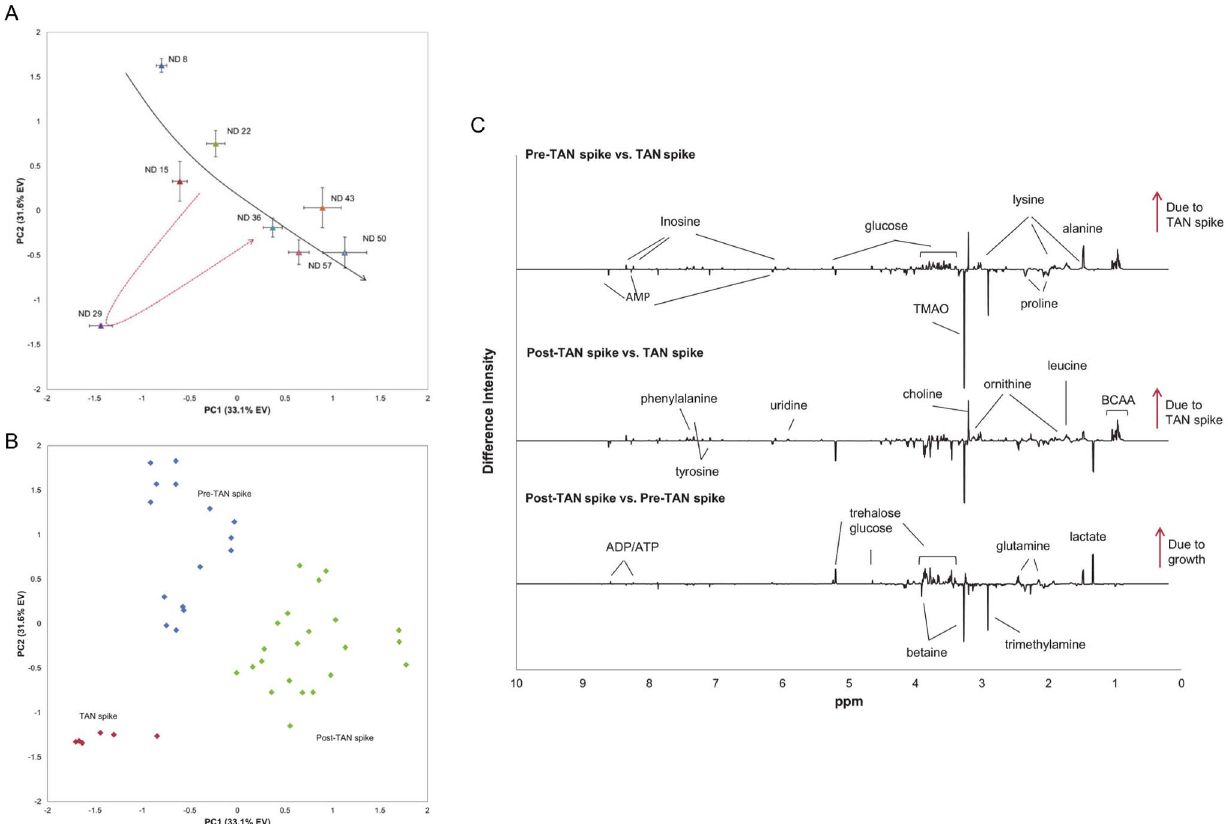
Figure 2. Nursery multivariate statistical analysis. Principal component analysis (PCA) scores plot of nursery phase shrimp. (A) Each point represents the mean PC score for the sampling time point (ND: nursery phase day) and the error bars represent the standard error of the mean. The solid black arrow suggests metabolic changes in relationship to growth, while the dashed red arrow denotes a deviation from and a return to ‘‘normal’’ growth. (B) PCA scores plot of all nursery phase shrimp grouped by pre-event, event (TAN spike), and post event. (C) 1 H significant difference spectra (SDS) displaying metabolite changes in response to the TAN spike and growth. The top SDS spectrum compares pre-TAN spike vs. TAN spike, the middle spectrum compares TAN spike vs. post-TAN spike and the bottom spectrum compares pre-TAN spike vs. post-TAN spike. Metabolites increasing as a result of the TAN spike are positive in the top two spectra and metabolites increasing during growth are positive in the bottom spectrum. Not all compounds mentioned in the text are annotated here.